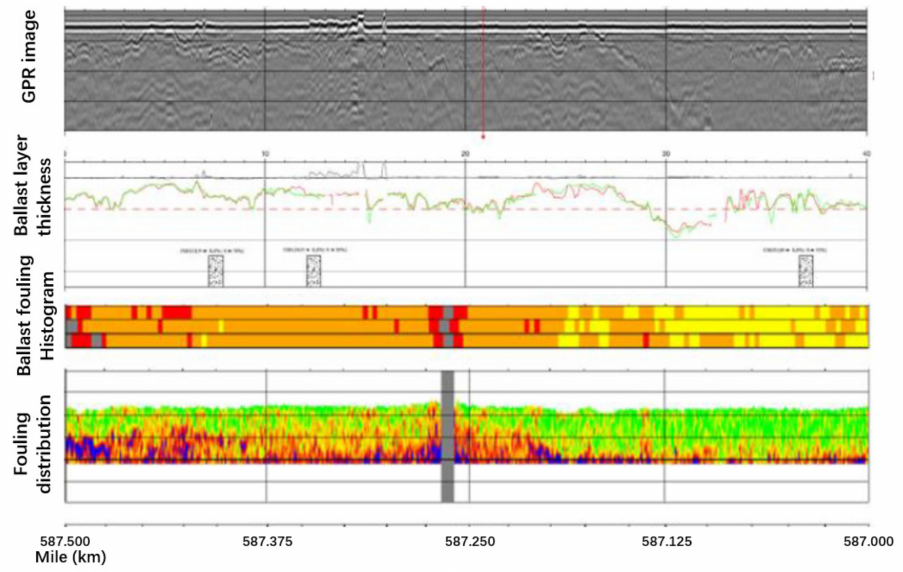
Figure 15. Output of Zetica’s system (figure modified after